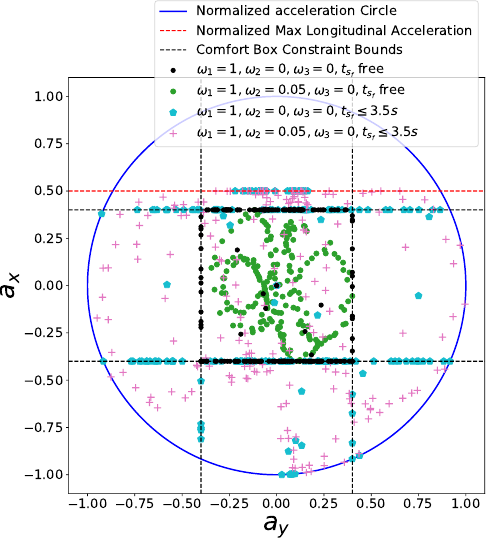
Figure 13. The g-g diagram of semi-hard comfort box